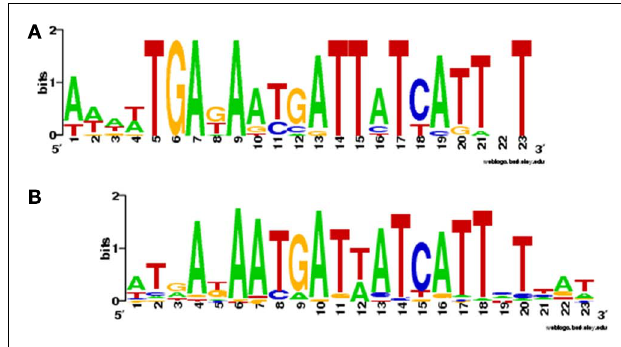
FIGURE 5 | Sequence logos for Zur boxes in cyanobacteria. (A) Consensus sequence developed by Haas et al. (2009), using 14 sequences found upstream of COG0523 genes in Prochlorococcus marinus sp. CCMP1986, P. marinus sp. CCMP1375, Nostoc sp. PCC 7120, Cyanothece sp. PCC 7424, Cyanothece sp. PCC 8802, Cyanothece sp. PCC 8801, Cyanothece sp. ATCC 51142, and Cyanothece sp. PCC 7425. (B) Consensus sequence deposited in the RegPrecise database (Novichkov et al., 2010) using 75 sequences from the genomes of Synechocystis PCC 6803, Synechococcus sp. PCC 7002, Synechococcus sp. PCC 7942, Synechococcus JA-3.3Ab, Thermosynechococcus elongatus BP-1, Synechococcus sp.WH8102, Prochlorococcus sp. MIT 9313, Trichodesmium erythraeum IMS101, Cyanothece sp. PCC 7425, Cyanothece sp. PCC 8801, Cyanothece sp. ATCC 51142, Microcystis aeruginosa NIES-483, Nostoc sp. PCC 7120, and Gloeobacter violaceus PCC 7421.There are clear similarities between the two logos as indicated by the suggested alignment of parts A and